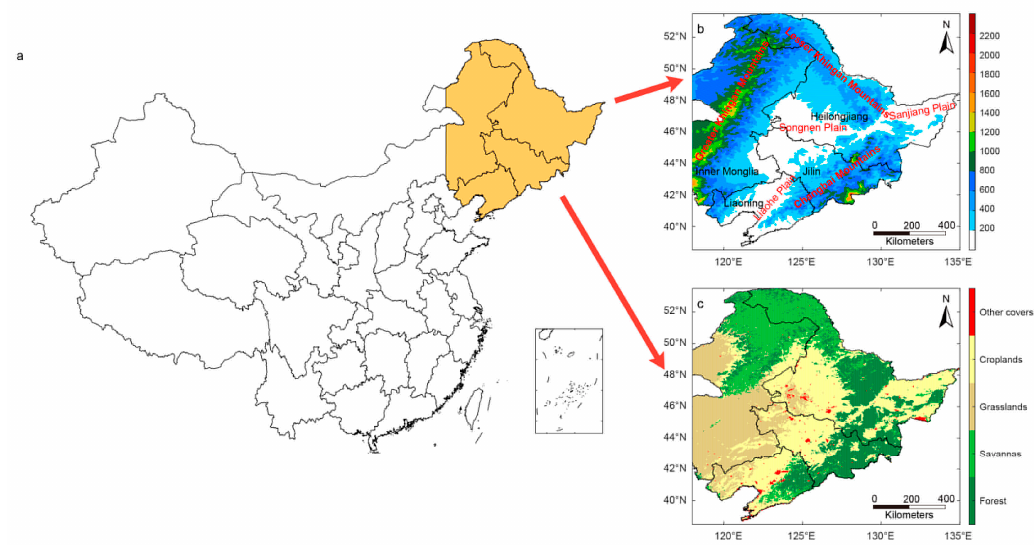
Figure 1. ( a ) Location of study area, ( b ) topographic map, and ( c ) distribution of land cover types in northeastern